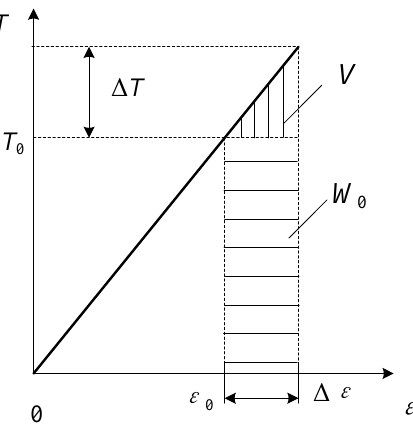
Figure 1. Potential energy and strain energy in initial tension.